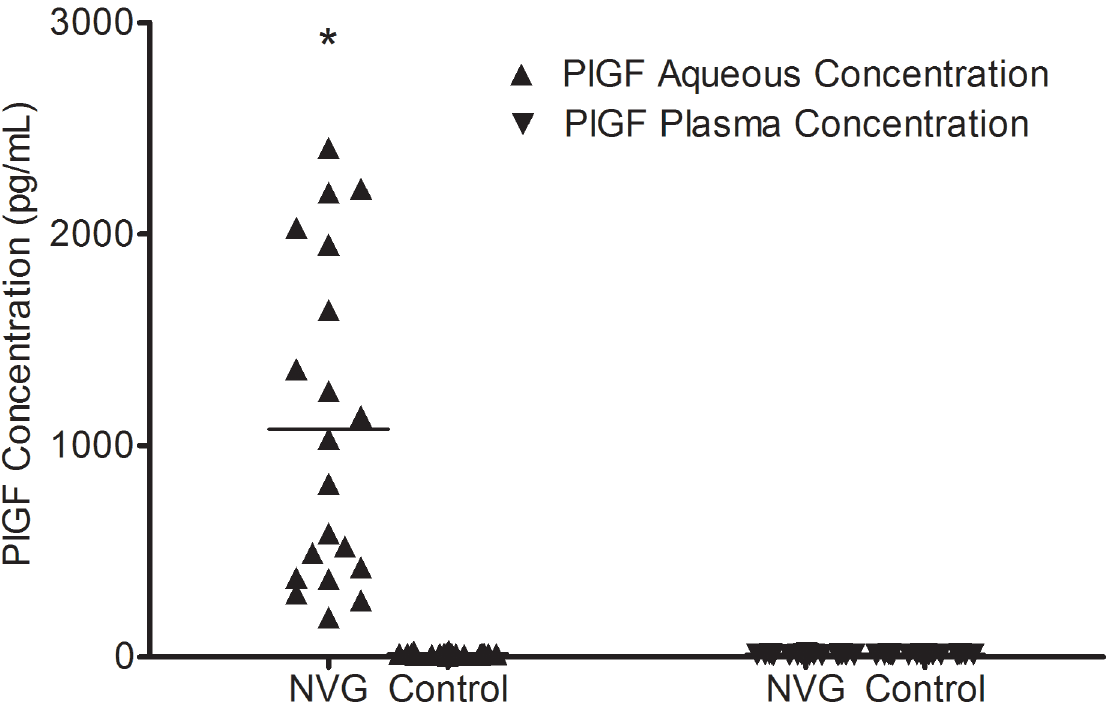
Fig 2. PlGF levels of the aqueous humor. The PlGF levels of the aqueous humor were significantly different between the groups ( * p < 0.001), whereas there was no significant difference in serum PlGF concentrations between the groups (p = 0.115).